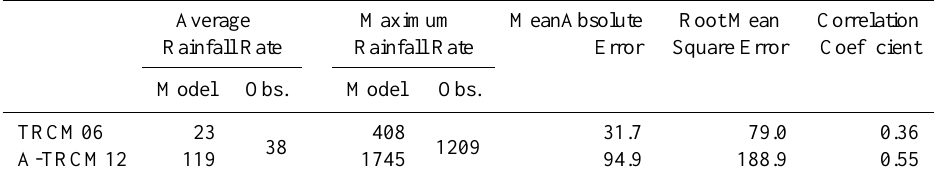
Table 7. Validation results for the statistical parameters of independent accompanied typhoons that hit Taiwan in 2007–2011. Average Maximum MeanAbsolute Root Mean Correlation Rainfall Rate Rainfall Rate Error Square Error Model Obs. Model Obs.